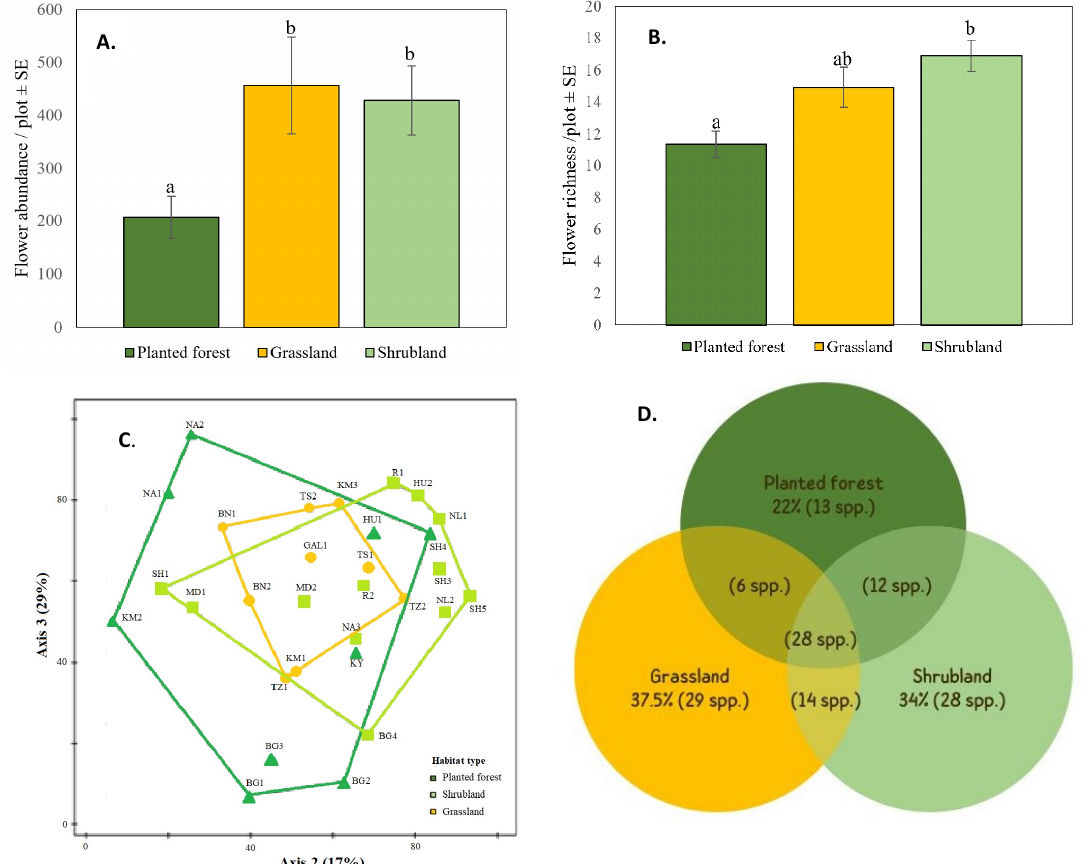
Figure 3. Uncultivated habitat characteristics: ( A ) Mean ( ± SE) flower abundance (columns with different letters differ significantly at p < 0.05; GLMM analysis); ( B ) mean ( ± SE) flower species richness; ( C ) flower species composition (based on NMS; p < 0.01, Stress = 15.1, three dimension, 45.9% of variance explained); and ( D ) shared vs. unique flower species in the three habitats (the unique species are of the total number of species per habitat type; n = 9 for the shrubland and planted forest, n = 12 for the grassland).